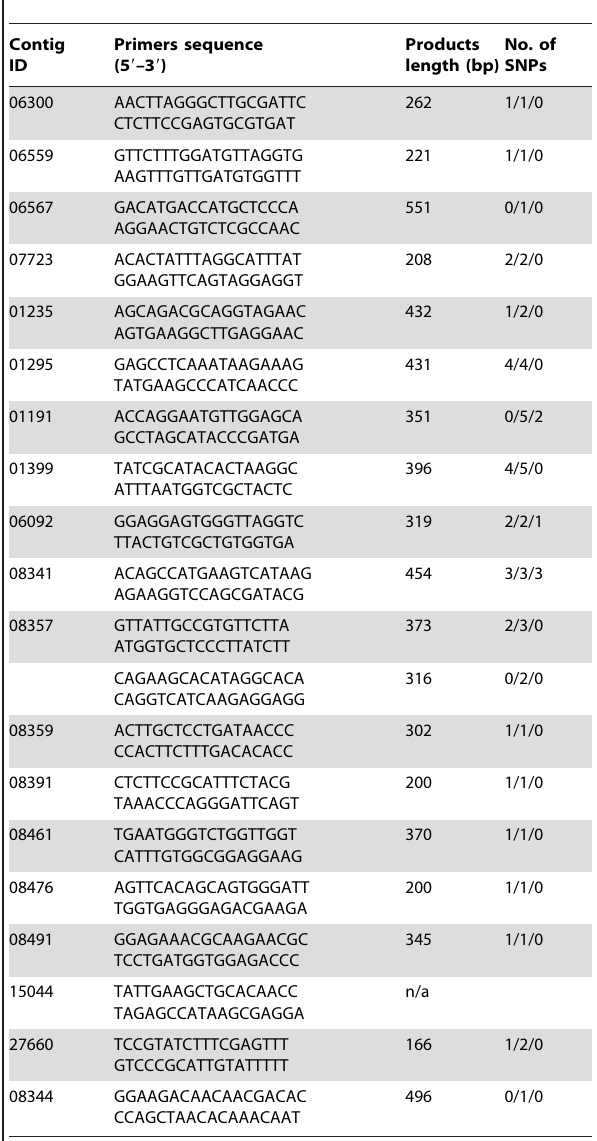
Table 3. Primers used and verified SNPs in the ESTs of M. nipponense